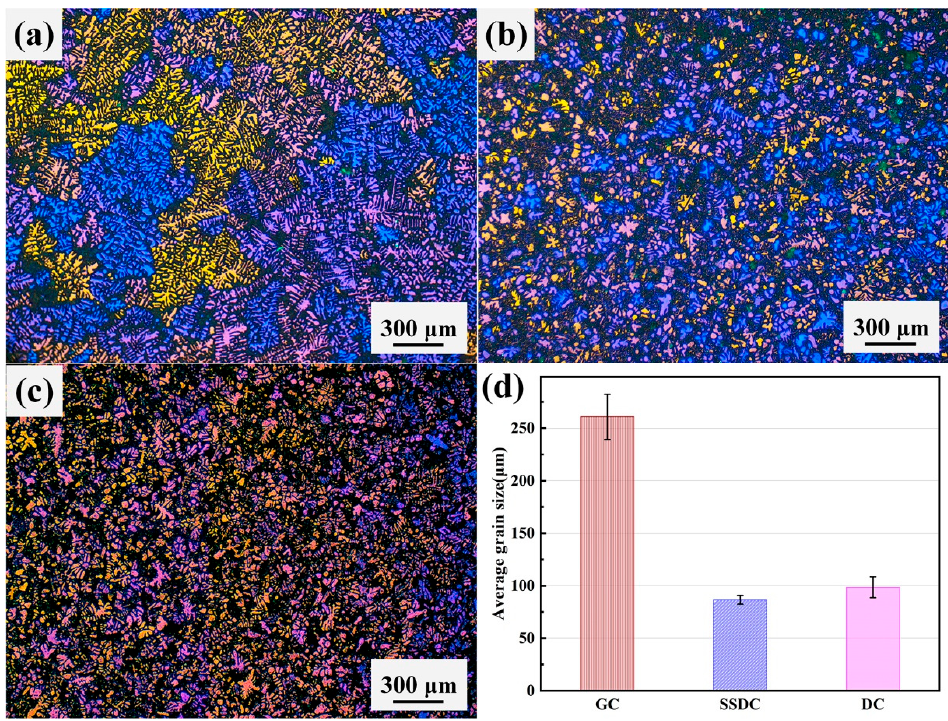
Figure 1. As-cast microstructure of polarized optical microscope: ( a ) alloy GC, ( b ) alloy SSDC, ( c ) alloy DC and ( d ) average grain size.